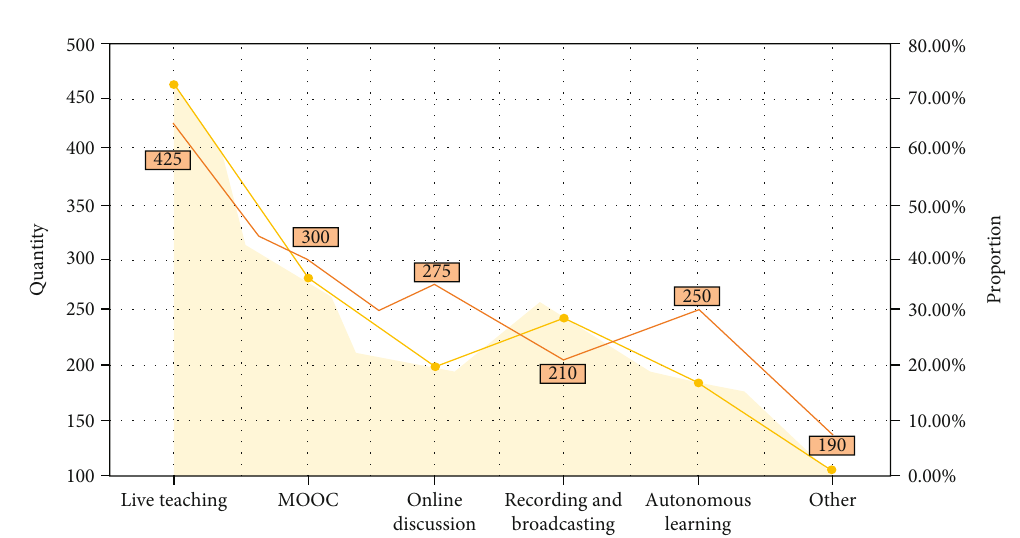
Figure 1: Flow chart of research ideas.